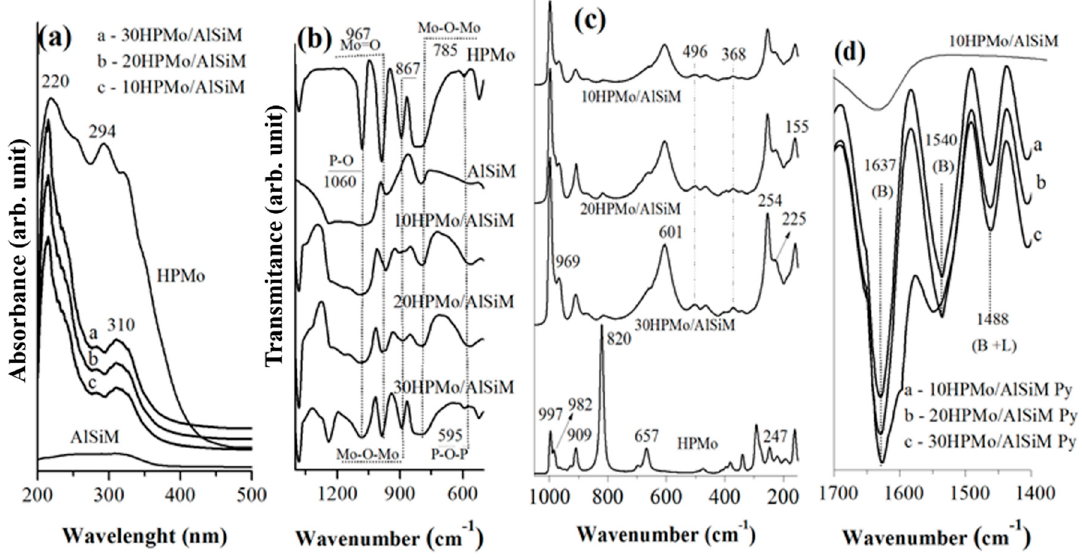
Figure 4. Diffuse reflectance spectroscopy (DRS) spectra of HPMo, AlSiM and (10, 20 and 30) HPMo/AlSiM samples ( a ); Fourier transform infrared spectroscopy (FTIR) spectra of the HPMo, AlSiM and (10, 20 and 30) HPMo/AlSiM ( b ) samples; Raman spectra of HPMo and (10, 20 and 30) HPMo/AlSiM ( c ); FTIR spectra of pyridine adsorption of samples (10, 20 and 30) HPMo/AlSiM ( d ).